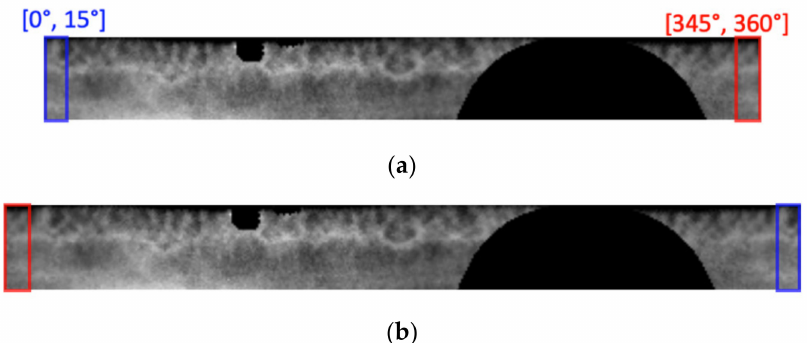
Figure 10. ( a ) Unrolled referent iris pattern; ( b ) extended referent iris pattern with redundant pixels at two